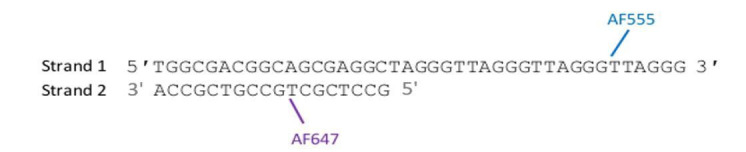
Intramolecular (F-22G3) forming sequence (top) and hybridisation sequence (bottom).